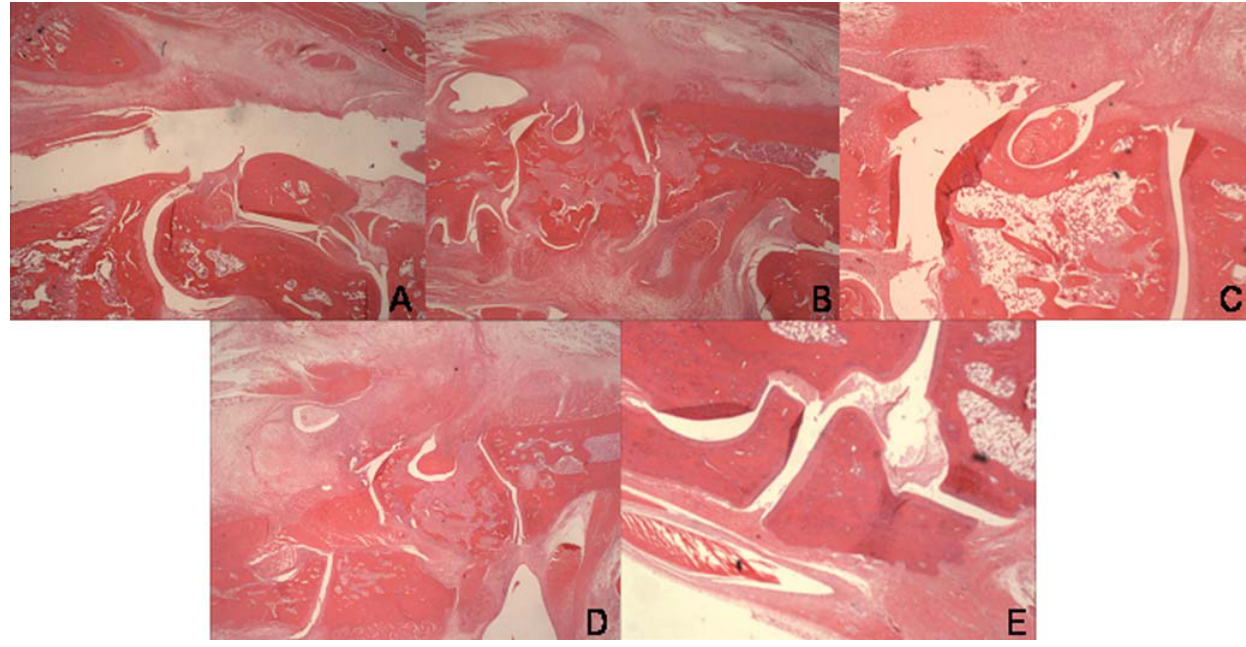
Figure 2. Combination therapy as well as a full course of Etanercept treatment led to reduction of histological damage in the ankle joints. Joints were harvested on day 23 after the induction of arthritis. Formalin-fixed tissues were decalcified, and glass slides stained with H&E were prepared. Submitted tissue sections were examined by light microscopy and scored for severity of inflammation of the synovium, pannus formation, cartilage damage, bone marrow inflammation and periostal proliferation, with a maximum score of 4 per parameter. N=3–4 per treatment group. H&E staining is shown of one rat per treatment, representative for the whole treatment group. A: Combination therapy; B: Etanercept 1 6 ; C: Peptide Mt. 180-188 4 6 monotherapy; D: No treatment; E: Etanercept 3 6 .